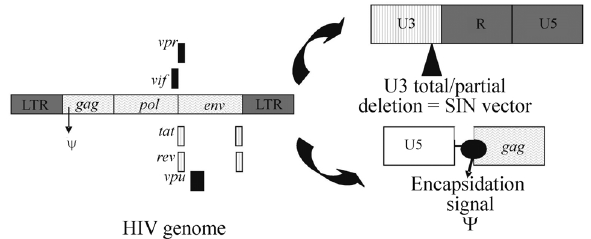
Figure 5 - Alterations of the HIV genome. Genes such as vpr, vif and vpu that are deleted from the transfer vector (black). Structural genes such as gag, pol and env (light gray). Long terminal repeat composed of the U3, R and U5 segments (gray). When the U3 segment is partially or almost com- pletely deleted a self inactivating (SIN) vector is formed. Besides U3 modification, it is important to maintain the encapsidation signal psi in the transfer vector. Because the psi signal presents an overlapping of se- quences with gag gene, gag deletions must be carefully